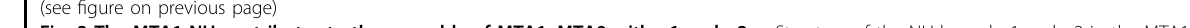
Fig. 3 The MTA1 NH contributes to the assembly of MTA1 – MTA9 with p1 and p2. a Structure of the NH-bound p1 and p2 in the MTA1 complex. Three interaction interfaces (shown in blue, black, and red rectangles, respectively) can be observed between MTA1 (magenta), p1 (cyan), and p2 (wheat). b – d Close-up views of the insets shown in a . e , f SEC analysis for the truncated versions of MTA1. MTA1 139 – 372 containing the NH can interact with p1 and p2, further forming the quaternary MTA1 139 – 372 – MTA9 – p1 – p2 complex with MTA9 ( e ). MTA1 171 – 372 without the NH retained the binding capacity with MTA9, but showed no interaction with p1 and p2 ( f